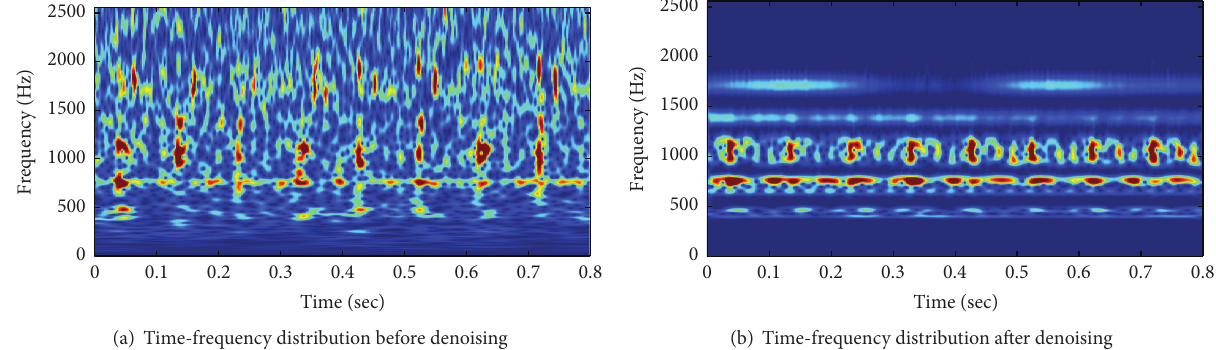
Figure 7: Time-frequency distribution of the vibration signal.